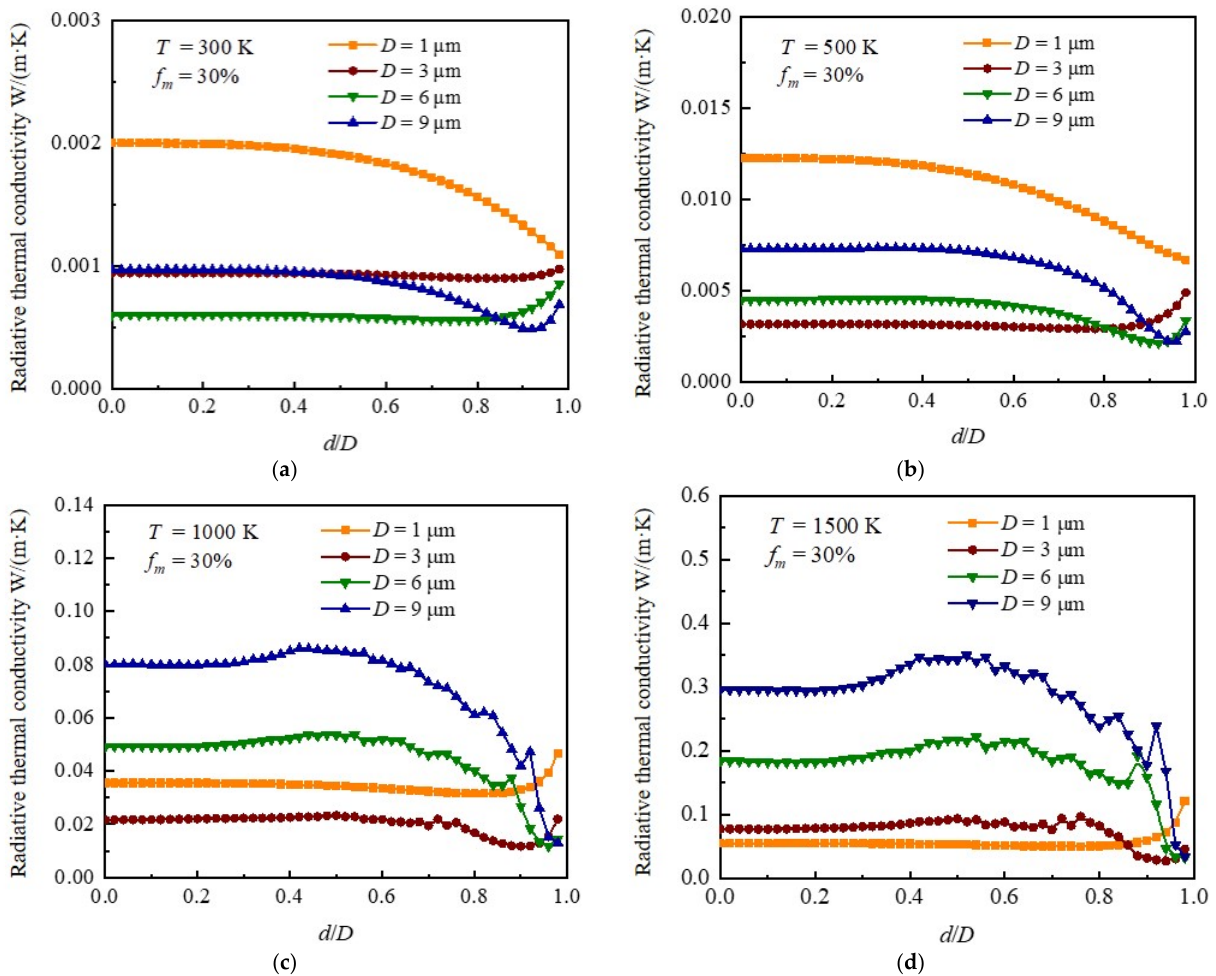
Figure 4. Influence of shell thickness on the radiative thermal conductivity of silica aerogel composites doped with hollow opacifiers with a mass fraction of 30%. ( a ) Radiative thermal conductivity of hollow opacifier-doped silica aerogel at 300 K as a function of shell thickness. ( b ) Radiative thermal conductivity of hollow opacifier-doped silica aerogel composite at 500 K as a function of shell thickness. ( c ) Radiative thermal conductivity of hollow opacifier-doped silica aerogel composite at 1000 K as a function of shell thickness. ( d ) Radiative thermal conductivity of hollow opacifier-doped silica aerogel composite at 1500 K as a function of shell thickness.